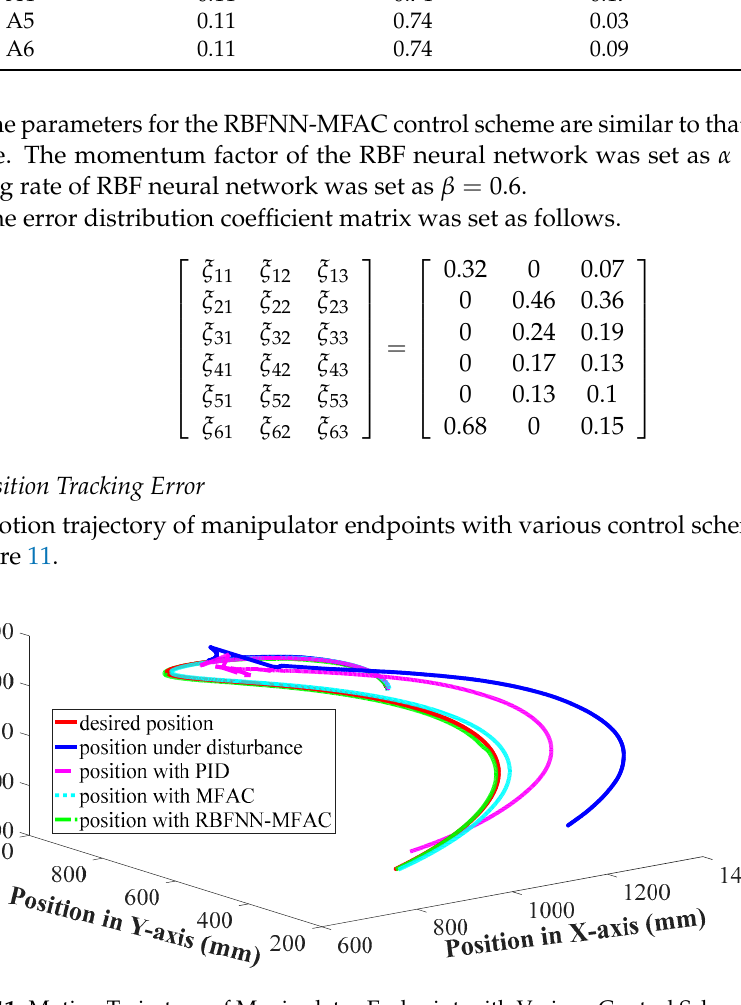
Figure 11. Motion Trajectory of Manipulator Endpoint with Various Control